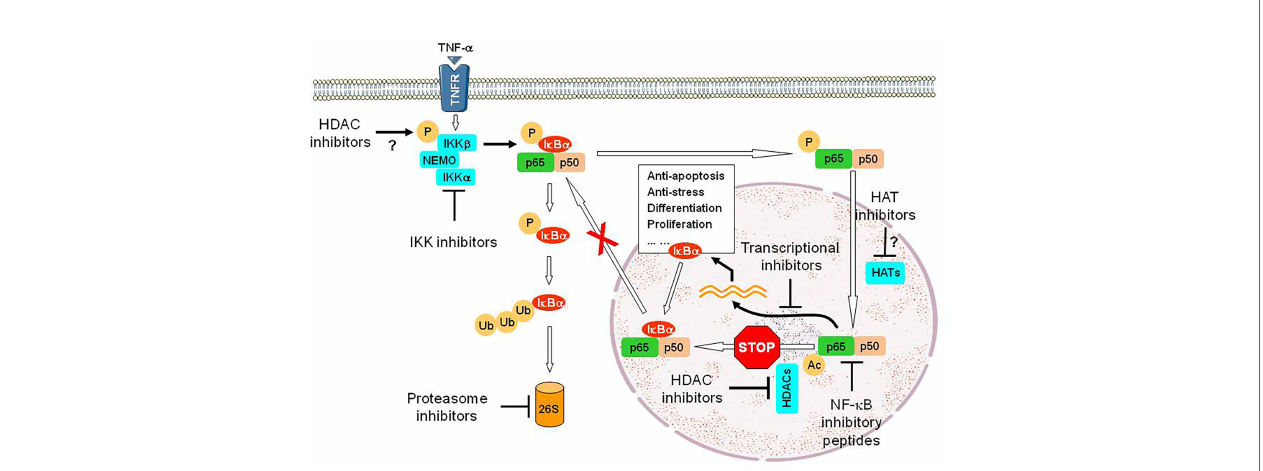
FIGURE 3 | An example for the DTT approach via linear inhibition. While HDAC inhibitors exhibit anti-tumor activity via multiple mechanisms of action, exposure to HDAC inhibitors however activates the NF- k B pathway via post-translational modi fi cations of RelA/p65, a major component of this critical survival pathway, including phosphorylation mediated by IKK b (the mechanism for IKK activation by HDAC inhibitors remains unclear) and then acetylation mediated by HATs, but failure of its deacetylation due to inhibition of nuclear HDACs (e.g., HDAC1-3). Hyperacetylation of RelA/p65 prevents its nuclear export via binding of de novo synthesized I k B a , a downstream gene of NF- k B, resulting in sustained activation of NF- k B signal and therefore counteracting the lethal action of HDAC inhibitors. Thus, a DTT approach via linear inhibition of this non-genetic survival pathway at multiple sites can eliminate such an “ off-target ” effect of HDAC inhibitors and improve their ef fi cacy as anti-tumor epigenetic therapy, though HDAC inhibitors often display limited single-agent activity. Disruption of these sites could involve IKK inhibitors that block phosphorylation of both I k B a and RelA/p65 (preventing I k B a degradation via the UPS and subsequent RelA/p65 entering into the nucleus), proteasome inhibitors that block proteasomal degradation of I k B a , (thus sequestering RelA/p65 in the cytoplasm), transcriptional inhibitors (e.g., inhibitors of CDK7 and CDK9) that block the expression of NF- k B-dependent genes), inhibitory peptides directly targeting RelA/p65 or its partner p50, and probably HAT inhibitors that block acetylation of RelA/p65. P, phosphorylation; Ub, ubiquitination; Ac, acetylation; 26S, 26S